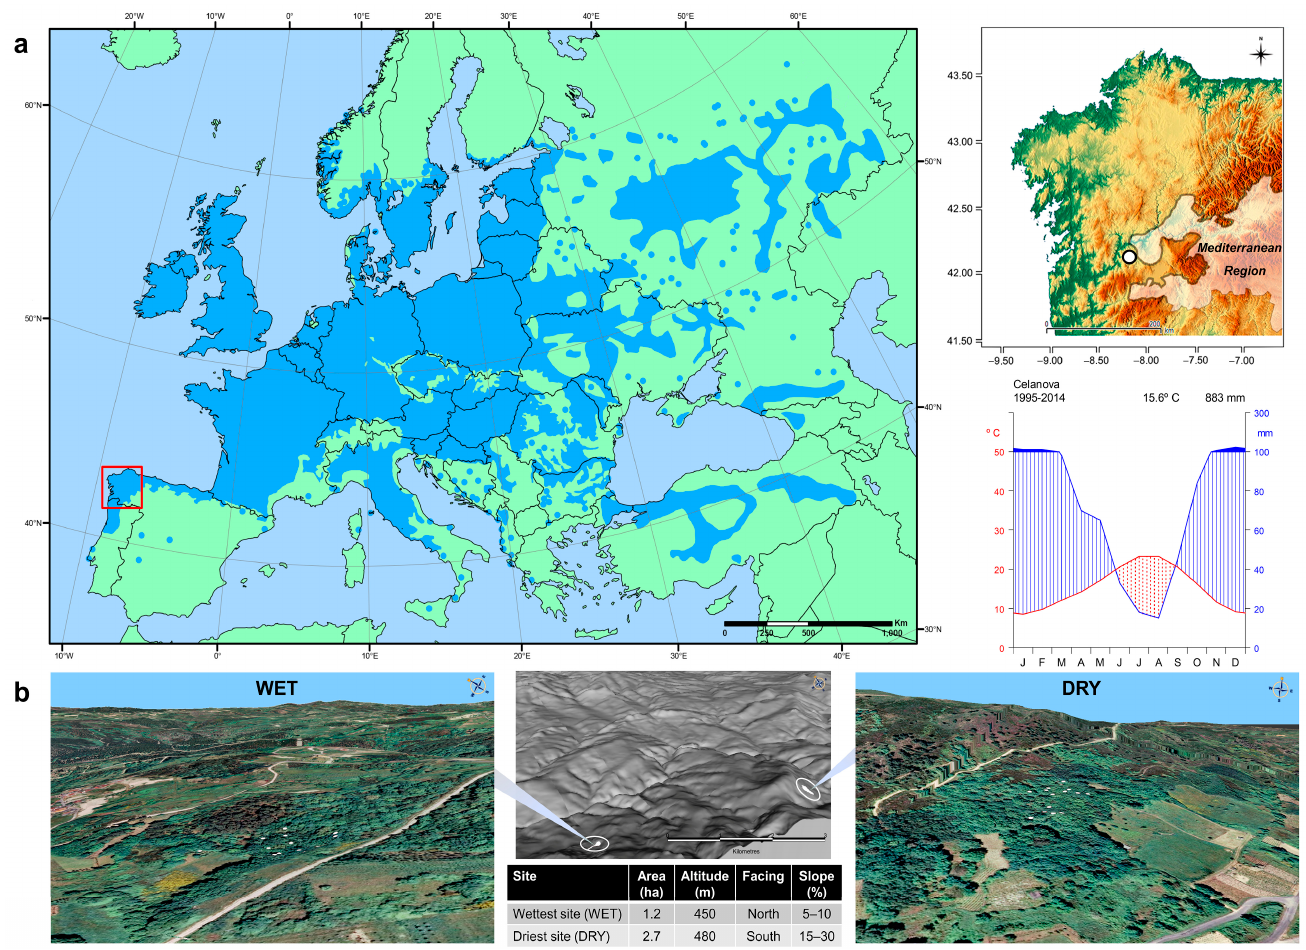
Figure 6. Natural distribution of Quercus robur (source: EUFORGEN 2009, https://www.euforgen.org/, accessed on 23 July 2015) and location of the study area at its southern range boundary in the Iberian Peninsula ( a ), showing the climate diagram from a nearby weather station. Digital Terrain Models with sampled trees as white dots and physiographic characterization of the two chronology sites are also included ( b ).